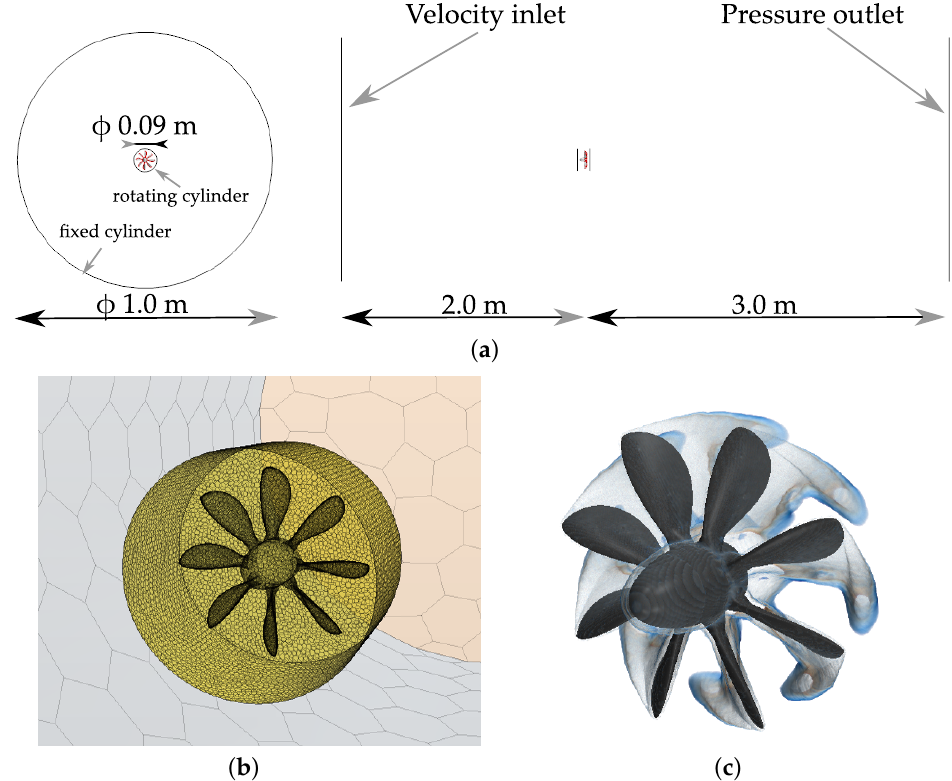
Figure 5. CFD analysis: ( a ) computational domain; ( b ) mesh; ( c ) vorticity scene.